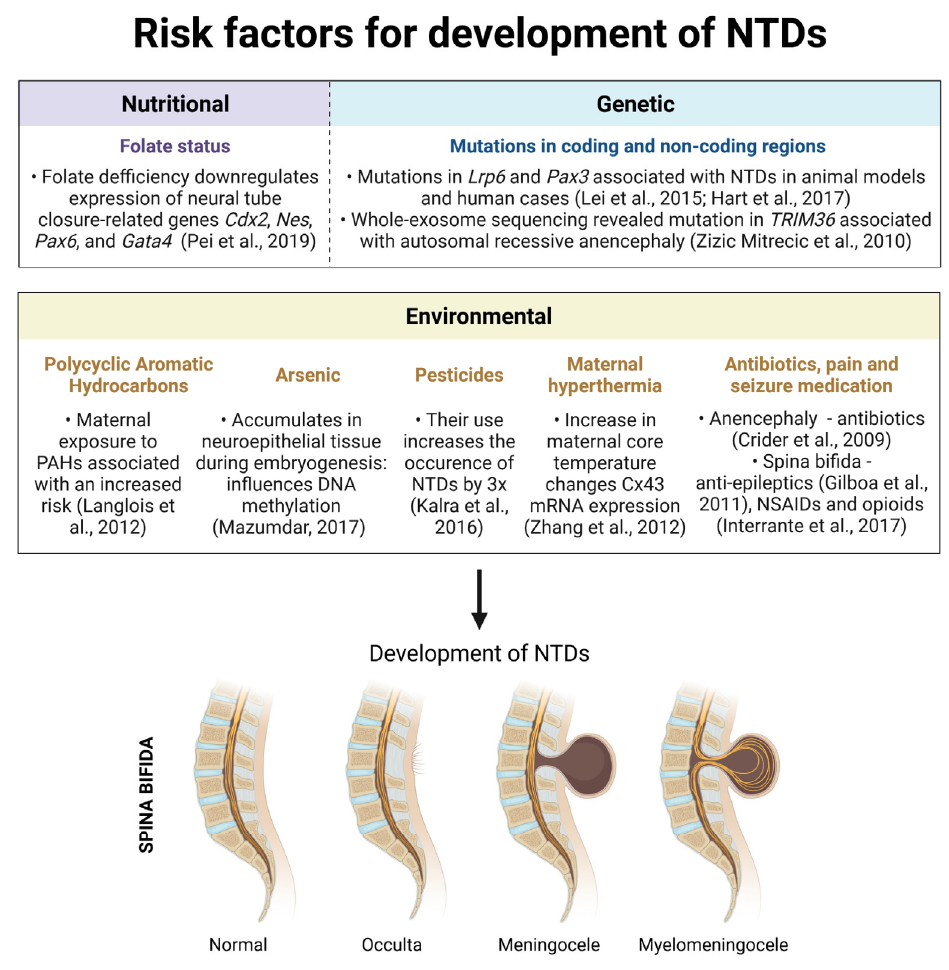
Figure 2. Summary of risk factors leading to development of NTDs. Created with www.BioRender. com (accessed on 26 March